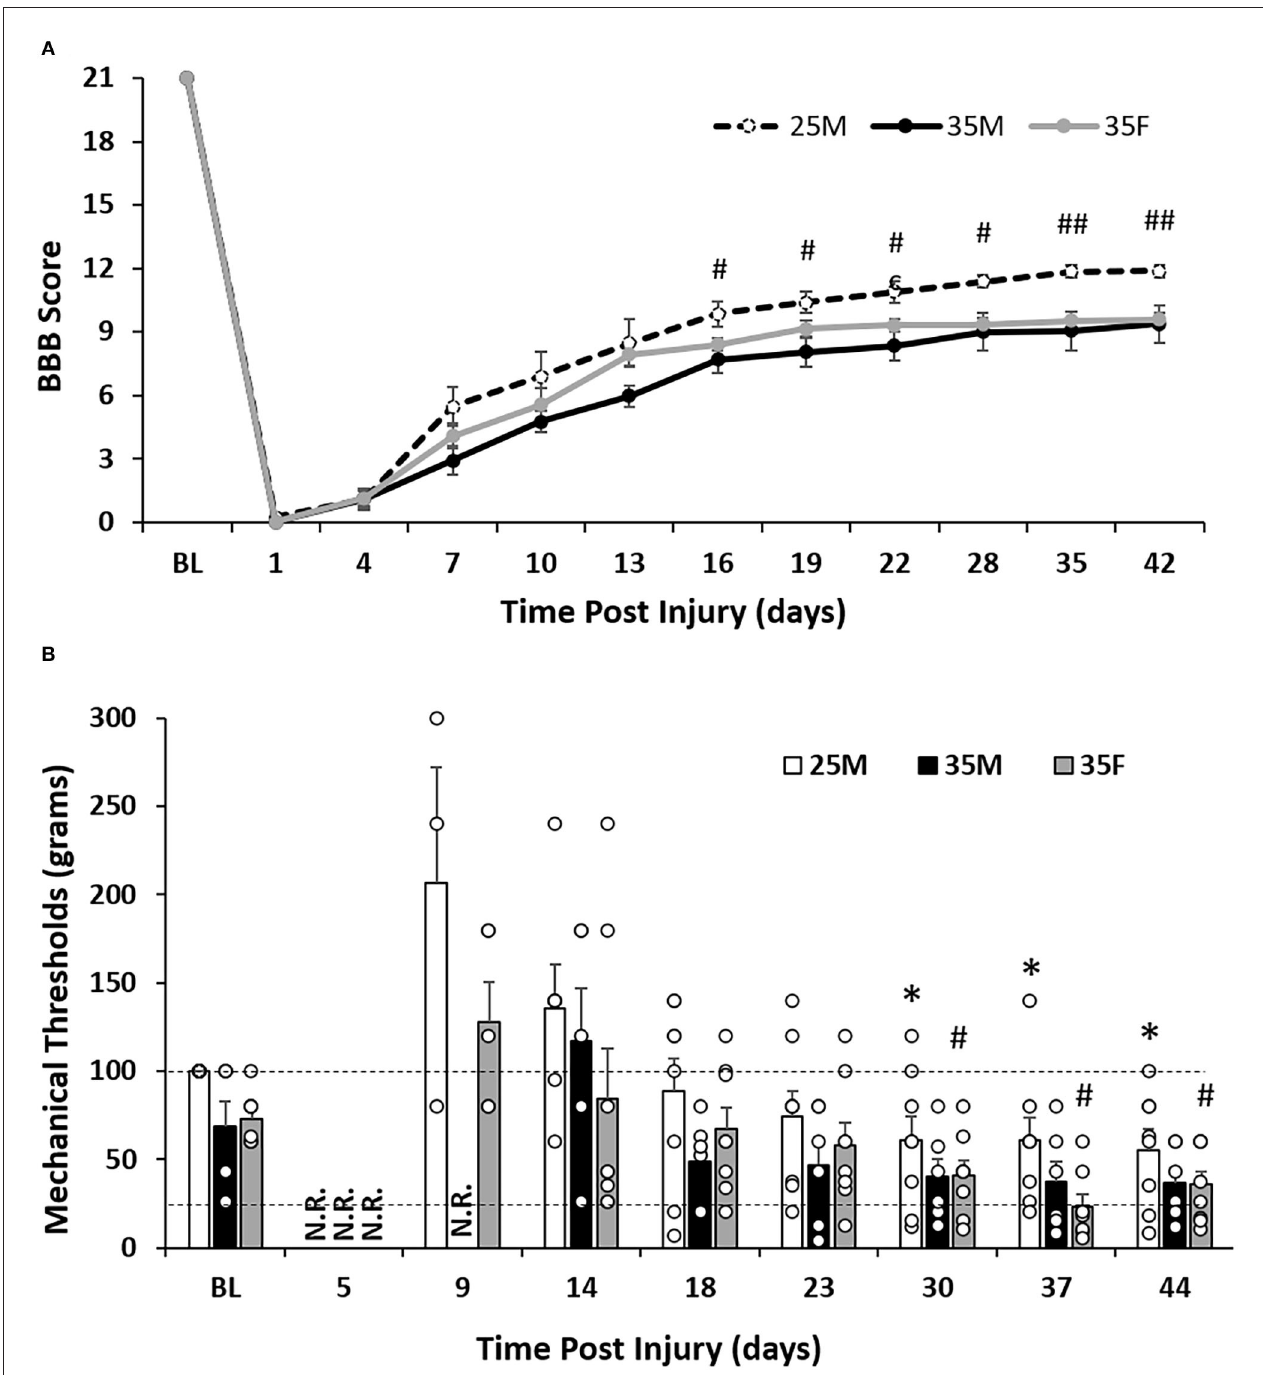
FIGURE 2 | Sensorimotor functional outcomes after SCI. (A) Level of functional recovery over time after SCI as assessed by BBB scale scoring. Data are presented as mean ± standard error of the mean (SEM) [ # p < 0.05; ## p < 0.01 between the 25M and 35M groups; repeated-measures analysis of variance (ANOVA)]. (B) Mechanical response thresholds assessed by the Von Frey manual test. Two dashed lines show response values of 26 and 100g, respectively. Data are presented as mean + SEM. For timepoint baseline, 18, 23, 30, 37, and 44 DPI ( n = 6 for the 35M group, n = 8 for the 25M and 35F groups); for timepoint five DPI ( n = 2 for the 35F group, n = 0 for the 25M and 35M groups); for timepoint nine DPI ( n = 5 for the 35F group, n = 3 for the 25M group, and n = 2 for the 35M group); and for timepoint 14 DPI ( n = 8 for the 35F group, n = 6 for the 25M group, and n = 5 for the 35M group). Groups had a minimum of three rats with recorded responses (* p < 0.05 comparing the 25M group at post-injury time points with 25M baseline; # p < 0.05 comparing the 35F group at post-injury time points with 35F baseline; repeated-measures Wilcoxon rank sum test). N.R., no record (no response to the highest filament size); BL, baseline.